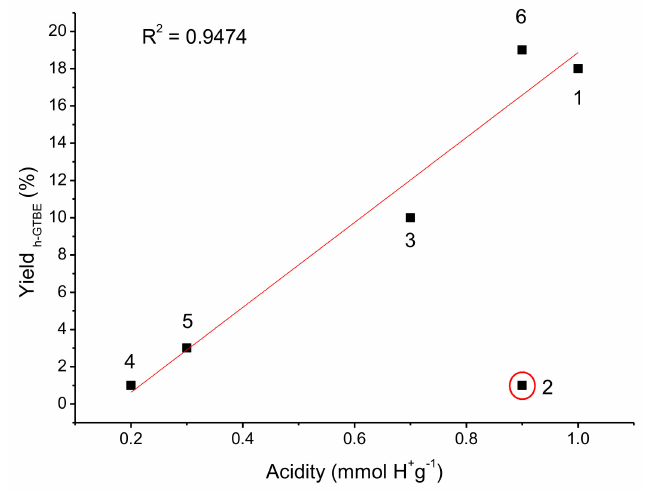
Figure 8. h-GTBE yield vs acidity (mmol H + / g) of the sulfonic catalysts 1–6 (T = 130 ◦ C; t = 10